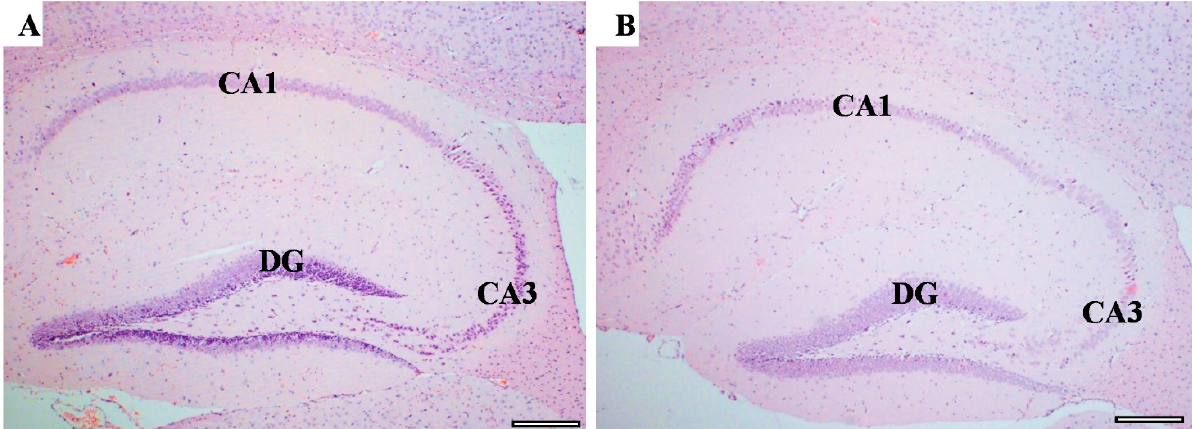
Figure 9. The hippocampus structure. H&E staining of hippocampus area sagittal section in both controls ( A ) and CUMS ( B ). The hippocampus areas CA1, CA3, and the dentate gyrus (DG) are the main areas that are involved in memory function. There is no interstitial bleeding or infiltration of inflammatory cells in CUMS group. Scale bar = 200 µm.